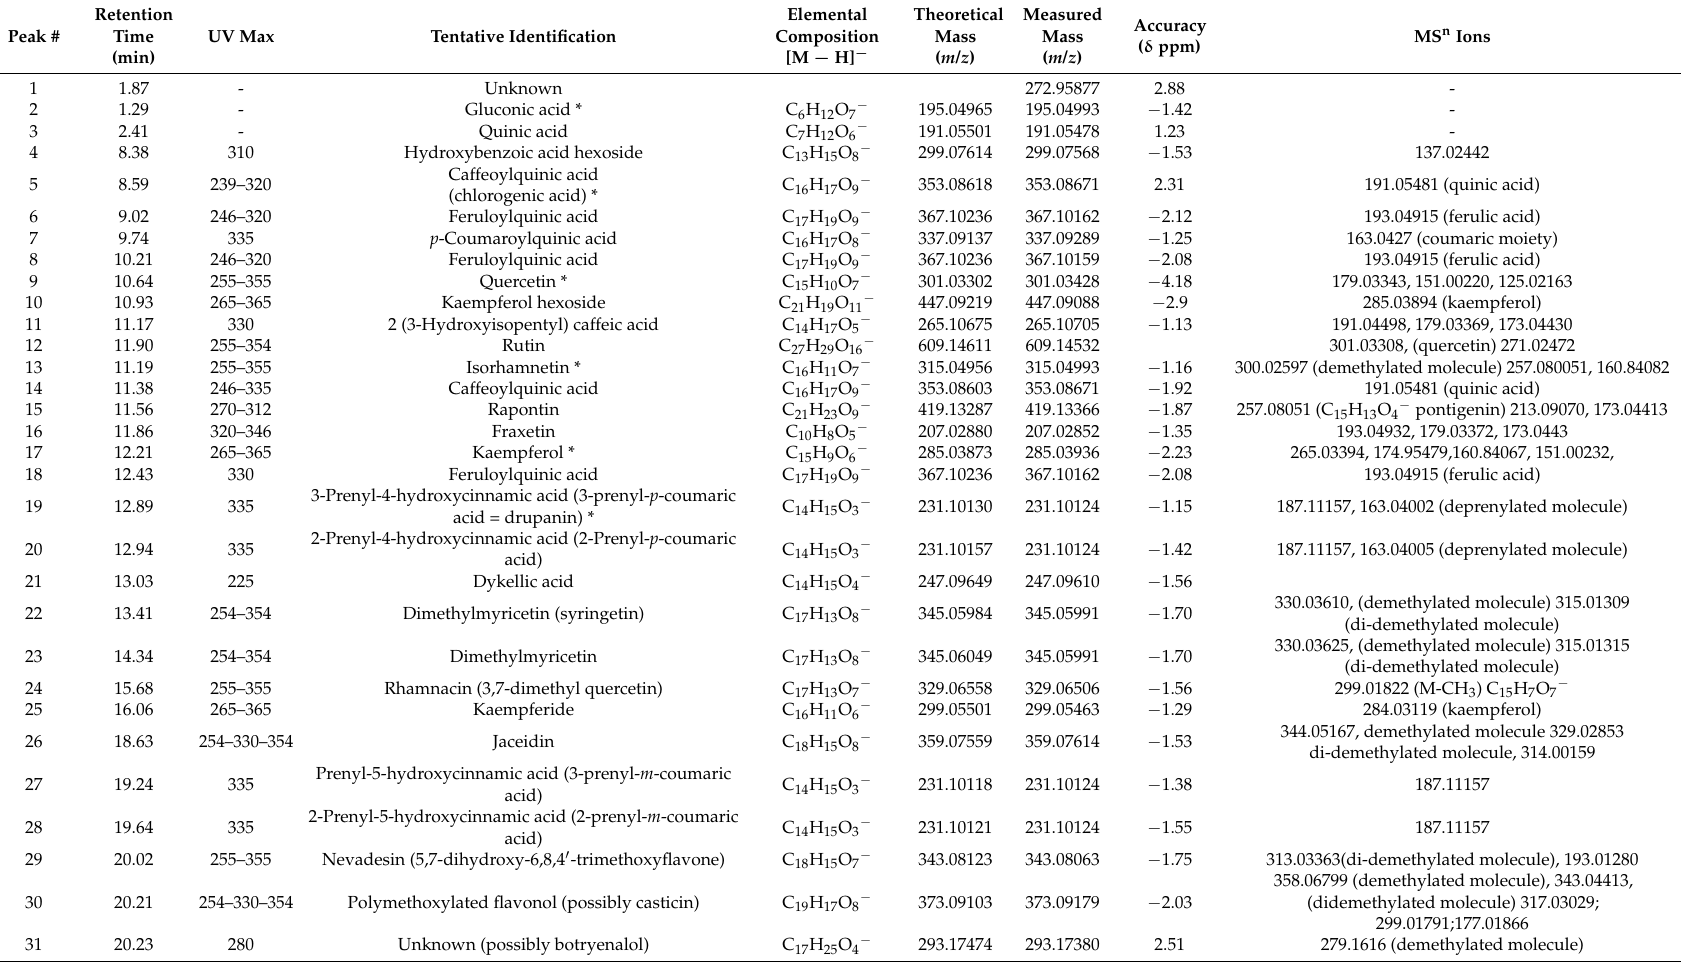
Table 3. High-resolution UHPLC PDA-Q orbitrap identification of metabolites in B. grisebachii lyophilized